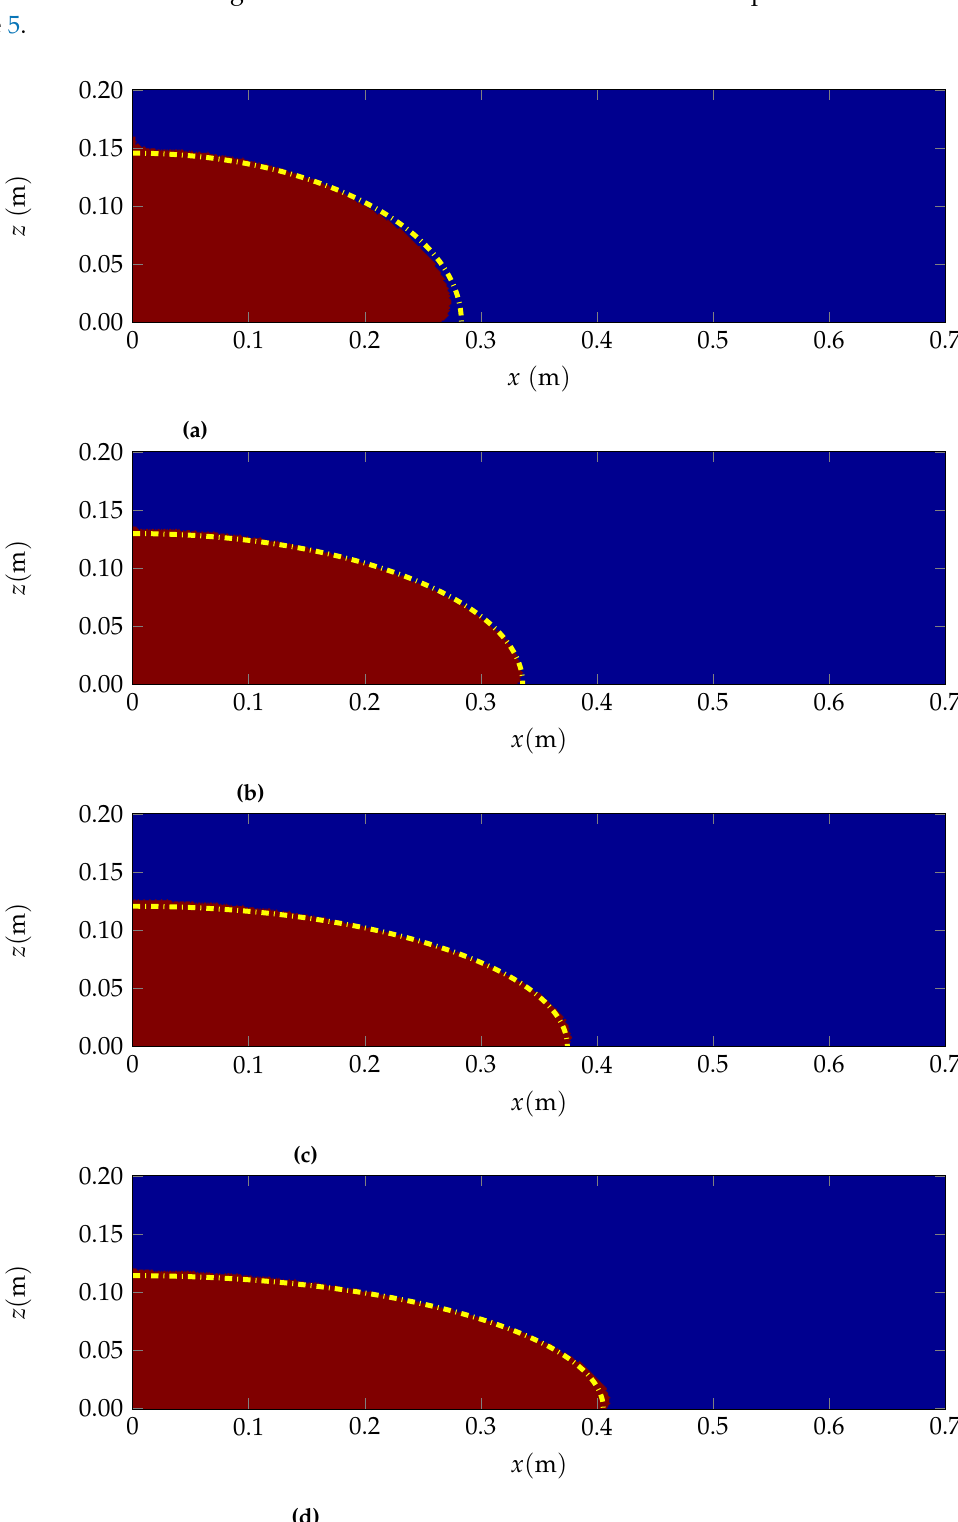
Figure 2. Comparisons in the y − z plane cross section between the NSE simulation and 1D flow model at ( a ) 1.3s, ( b ) 2.3s, ( c ) 3.3s, and ( d ) 4.3s. Red represents glycerol in the simulation results, the yellow dotted line is the free surface from the 1D